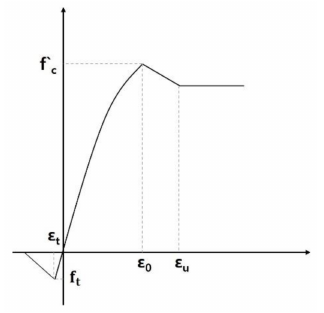
Figure 4. Constitutive model for concrete material.